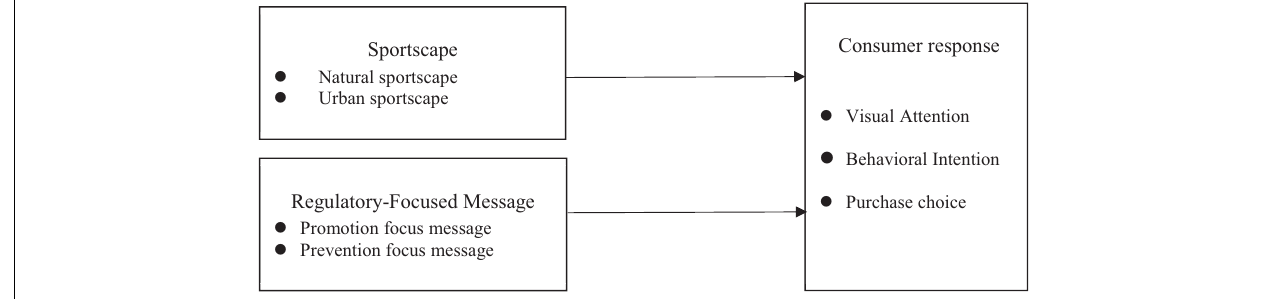
FIGURE 1 | Research framework. TABLE 1 | Experimental